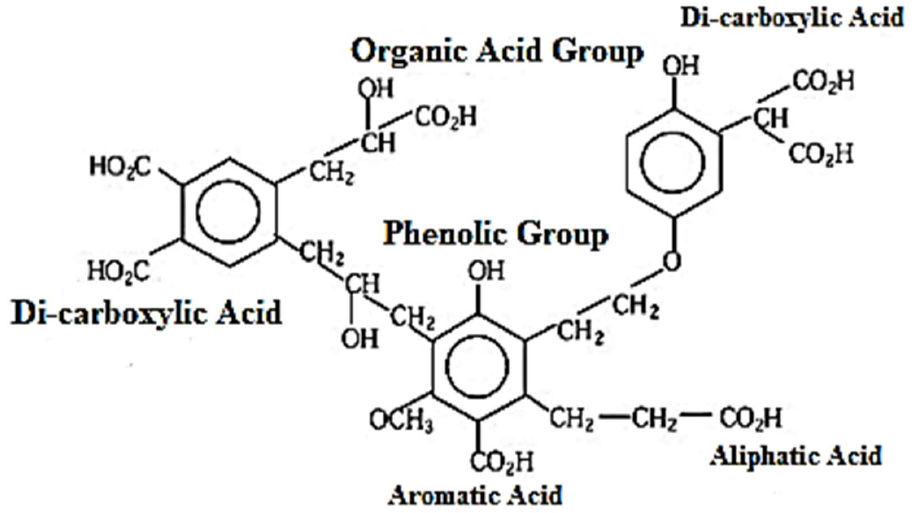
Figure 1. Typical humic acid